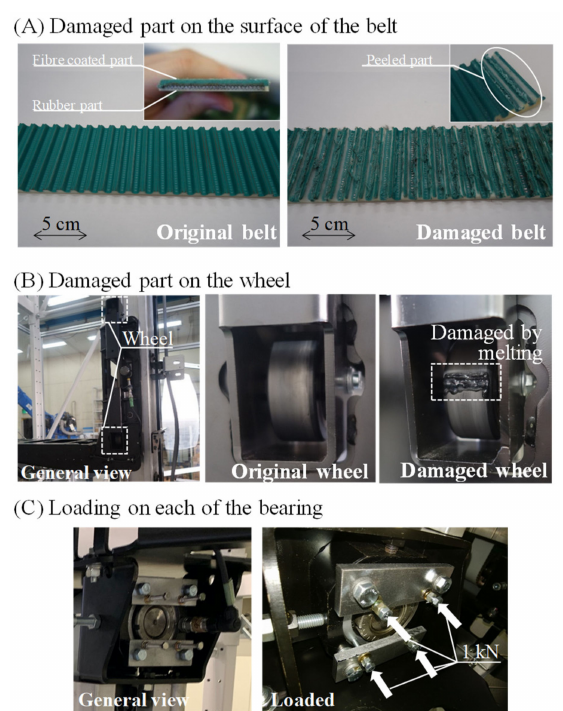
Figure12. Artificiallydamagedconditions: ( A )damagetobelt,( B )damagetoguidewheel,and( C )damage to